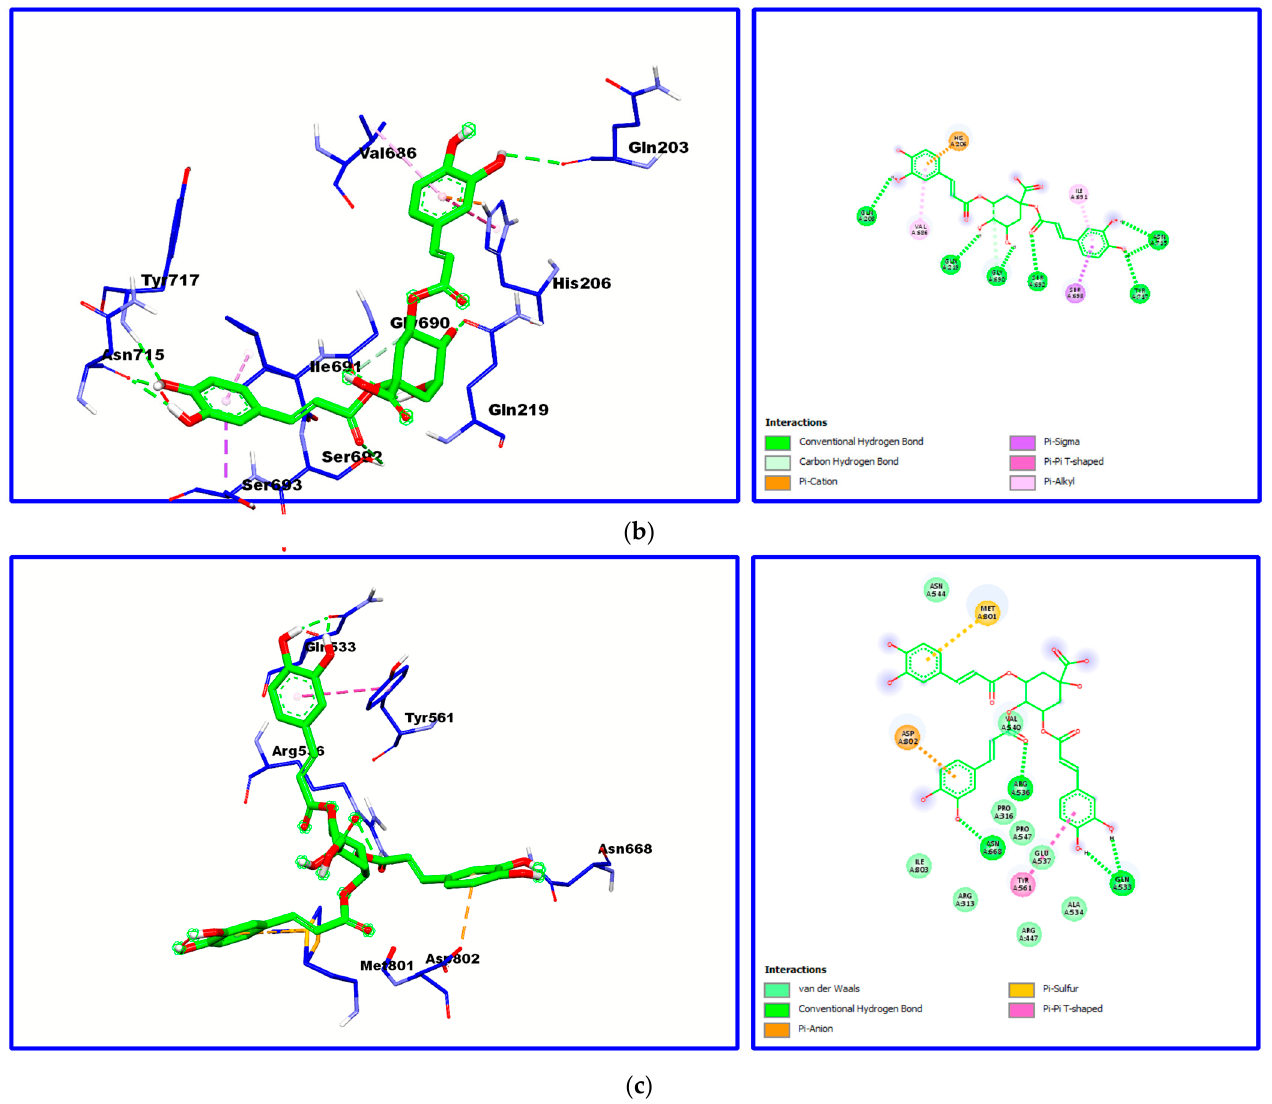
Figure 3. Two-dimensional and three-dimensional structures of the docked compounds taxifolin ( a ), 1,3- O -dicaffeoylquinic acid ( b ), and 4,5- O -dicaffeoylquinic acid ( c ) at the active site of α -glucosidase enzyme. Table 5. Binding energy and amino acids involved in the interactions between α -glucosidase enzyme and the docked